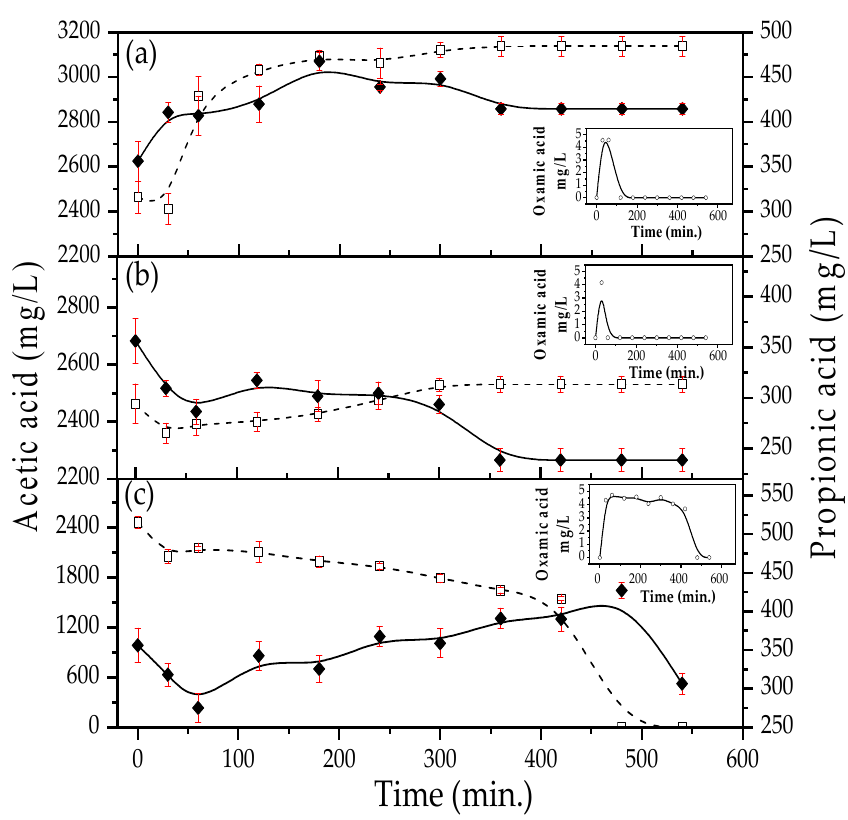
Figure 6. Evolution of carboxylic acid during electrolysis without the addition of electrolyte support at 25 °C and pH 4.28 applying 30 mA/cm 2 . ( a ) MMO-Cl 2 , ( b ) MMO-O 2 , and ( c ) BDD. The inset panels present the expansion of oxamic acid during each electrolysis: ( ○ ) Oxamic, ( □ ) Acetic, ( ♦ ) Propionic acids. Samples tested: 11.